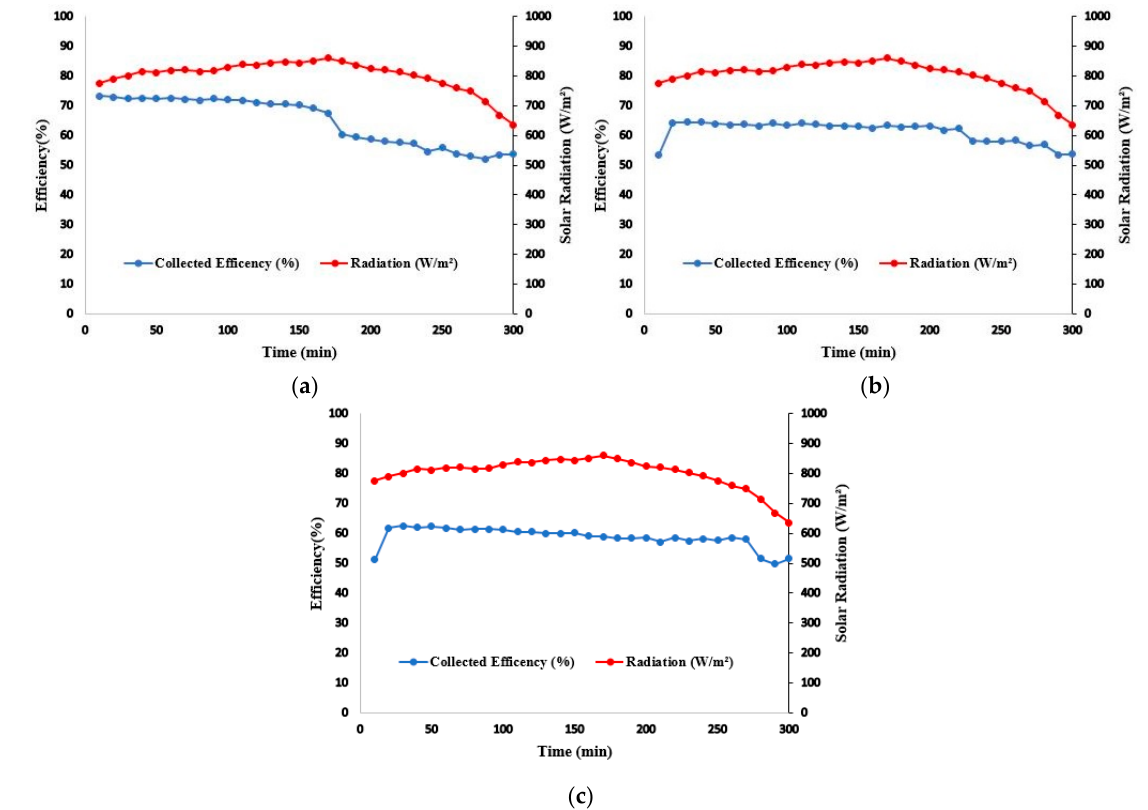
Figure 2. Collected efficiency using ( a ) Al 2 O 3 , ( b ) CuO, and ( c ) distilled water at 2 L/min.